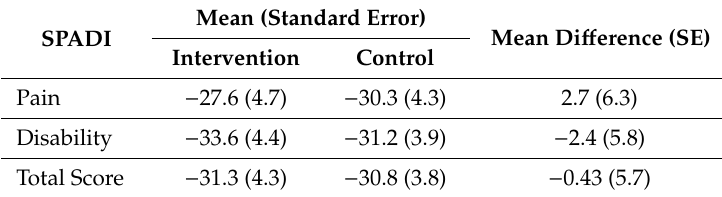
Table 4. SPADI–Change from Baseline to 26